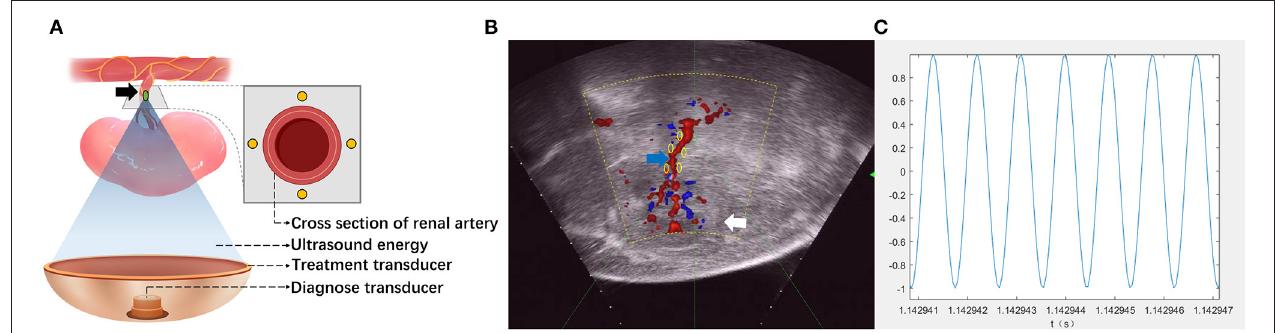
FIGURE 1 | Schematic of high-intensity focused ultrasound (HIFU) for renal sympathetic denervation (RDN). (A) Illustrating the simultaneous treatment and imaging modules of the HIFU system. The target of the HIFU system ( green spot ) was set near the wall of the renal artery. Locations of the treatment site on the cross section of renal artery appear as yellow spots . Black arrow : renal artery. (B) The target of HIFU system ( green spot ) was targeted by three-dimensional movement of the treatment transducer guided by color Doppler flow imaging (CDFI). The locations of treatment sites on the longitudinal section of renal artery appear as yellow spots . White arrows , kidney; blue arrow , renal artery. (C) The waveform of the released ultrasound